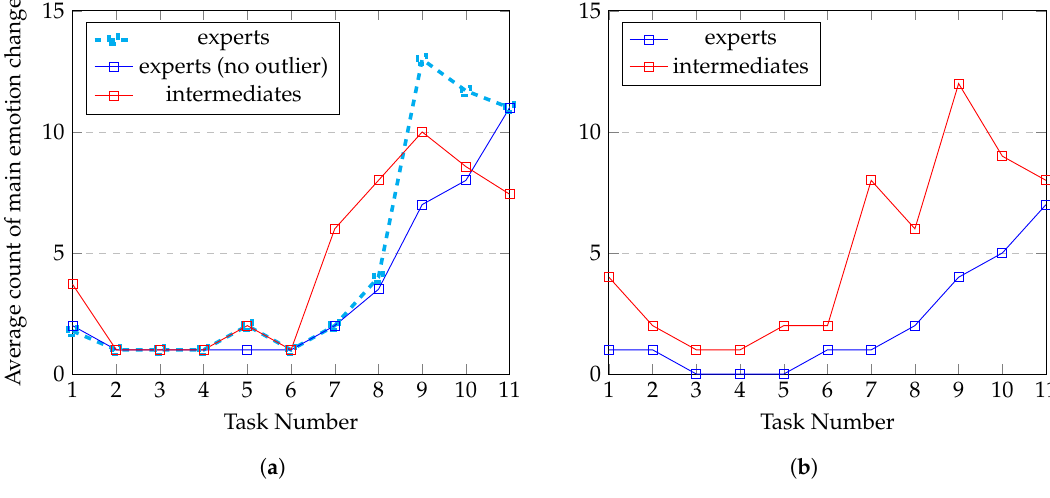
Figure 5. Average count of variation of main detected facial emotion in regard to the task (1–13). Tasks are ranging in an increasing difficulty order. ( a ) Current study analysis on 23 participants; ( b ) Previous study realized on 14